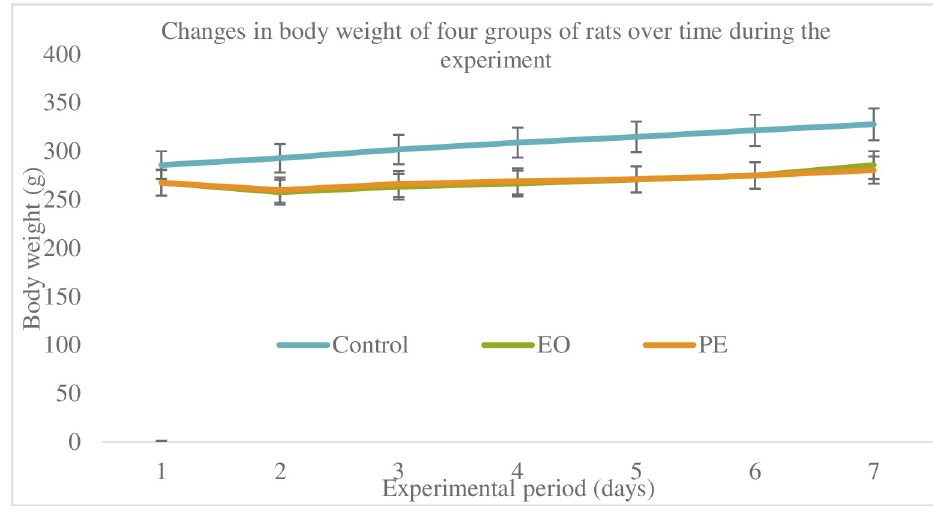
Fig 3. Changes in body weight of four groups of rats over time during the experiment.